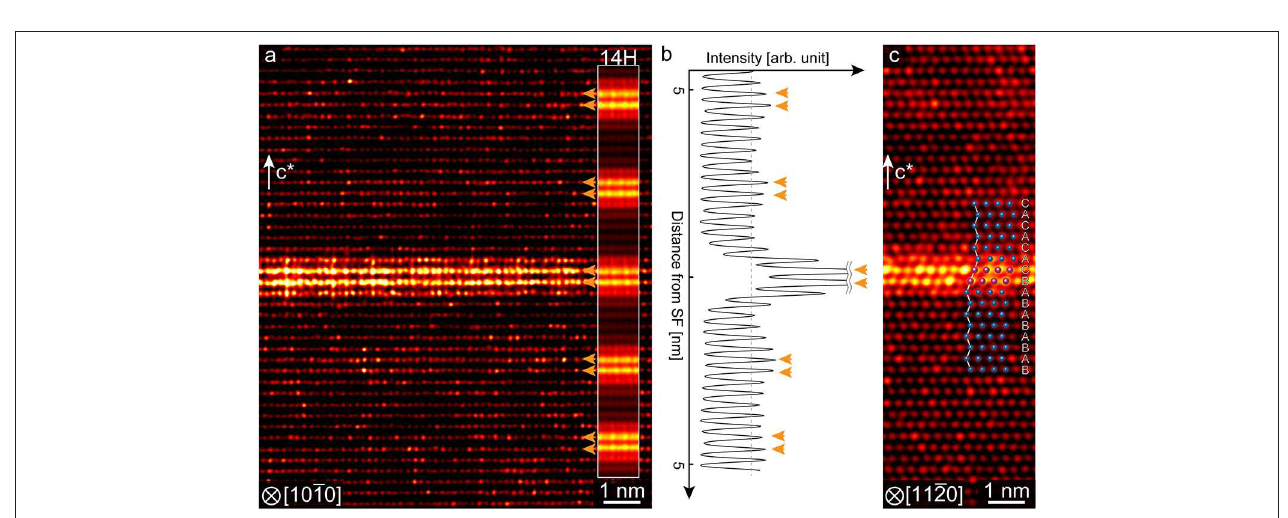
FIGURE 7 | (a) Atomic-resolution HAADF-STEM image of the α -Mg matrix with a single SESF, taken along the [10¯10] hcp direction. c* denotes the c -axis of the hcp crystal. A part of the 14H-type LPSO structure image is inserted for comparison, where the ordered arrays of the SESF are seen clearly. (b) Intensity profile of the entire image of (a) along the c -axis direction, in which weak intensity maxima are indicated by arrowheads. (c) HAADF-STEM image of the α -Mg matrix with a single SESF, taken along the [1¯210] hcp direction. Stacking sequences are unambiguously identified, as shown by the schematic model